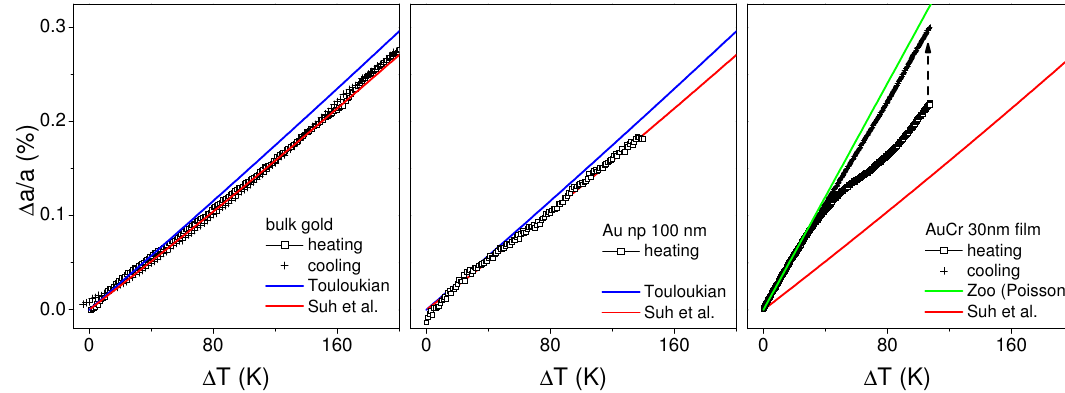
Figure 3. ( Left ) relative thermal expansion of a bulk gold plate as function of temperature rise above room temperature. The symbols mark heating ramp (dots) and cooling ramp (crosses). The lines are the calculated thermal expansion according to refs. [52] and [51]; ( Center ) relative thermal expansion of a single layer of spherical gold nanoparticles on a silicon wafer as function of temperature rise together with the calculated thermal expansion as in the left figure; ( Right ) relative thermal expansion of a sputtered gold film on silicon. The cooling curve is shifted for clarity to force overlap with the heating curve at ∆ T = 0 K (indicated by the arrow). The lines are the calculated bulk thermal expansion from [52] as well as a calculation assuming additional Poisson expansion